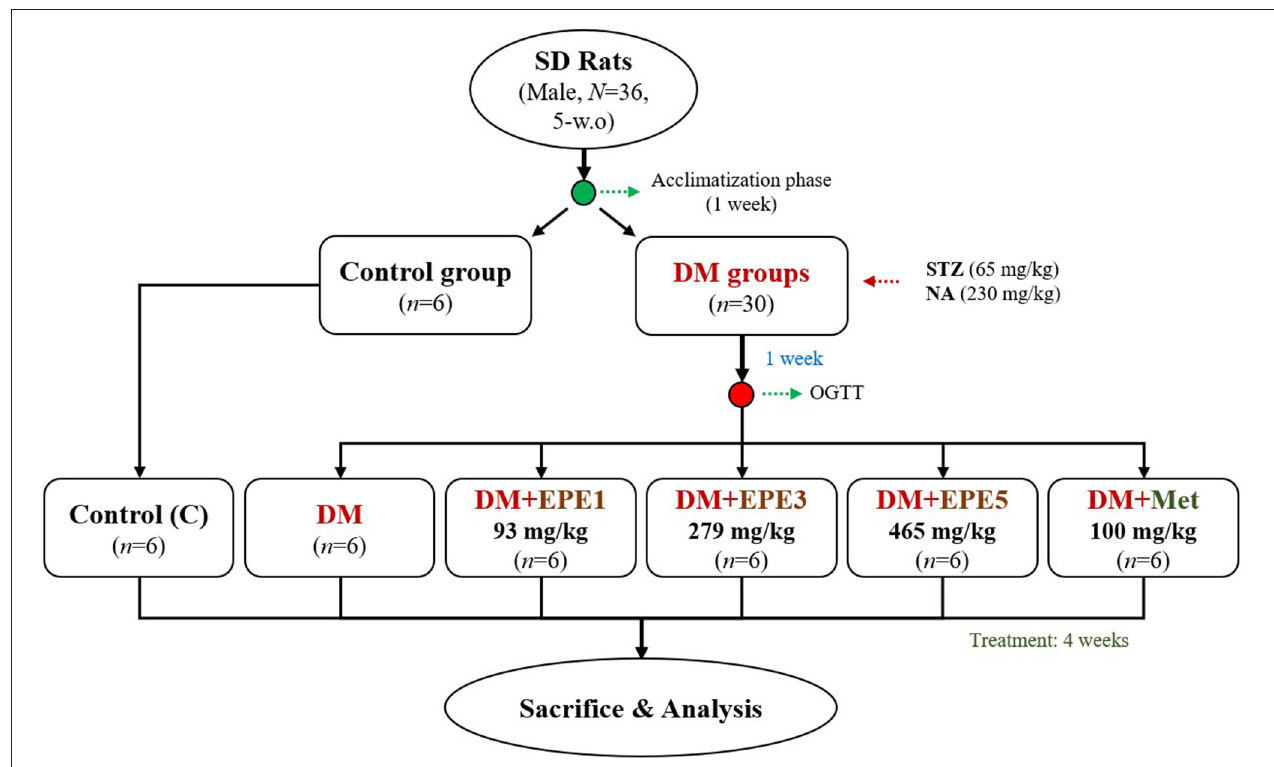
FIGURE 1 | The flowchart of Echinacea purpurea ethanol extract treatment against streptozotocin–nicotinamide-induced diabetes male rat model. DM, diabetes mellitus; EPE, Echinacea purpurea ethanol extract; Met, metformin.